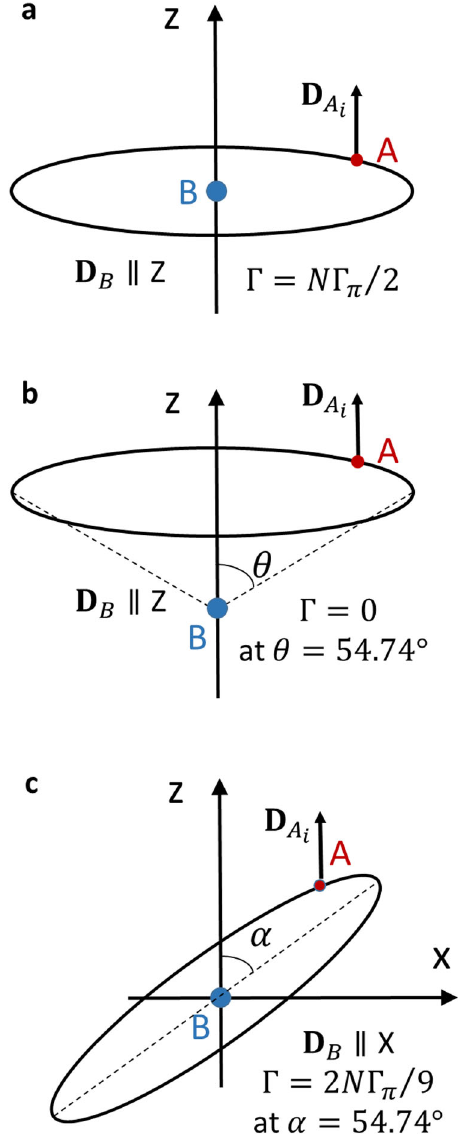
Fig. 2 ICD in a ring-impurity ensemble. a The ring is in the XY -plane with B in the center. The ICD rate is strongly enhanced in the cavity from Γ π without a cavity to N Γ π /2. b The ring is shifted along Z . The ICD rate now depends on the angle θ (Eq. 13). There is no ICD at all at the magic angle. c B is in the center and the ring is rotated around the Y axis. The transition dipole of B rotates from the Z axis into the XZ -plane and the ICD rate depends on the tilt angle α (Eq. 14). At the magic tilt angle, the transition dipole points parallel to the X